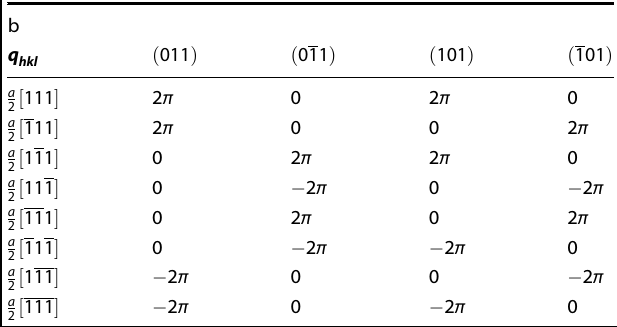
Fig. 5 Reconstructed strain in irradiated chromium crystal. a Rendering of the reconstructed lattice displacement with magnitude |u(r)| in the [101] direction. The superimposed arrows indicate the directions of x , y , and z -axes with the corresponding crystallographic directions. Also shown are three sections through the crystal for which strains are shown in (green, red, and purple). Six strain tensors and three rotation tensors components are plotted on the b x – y plane c y – z plane d x – z plane of the crystal. Representative tensile stripes are shown with black arrows while dislocation loops are shown using white circles. All scale bars correspond to 1.0 µm. Table 2. Visibility of dislocations with Burger ’ s vector b in crystal re fl ections with scattering vector q hkl